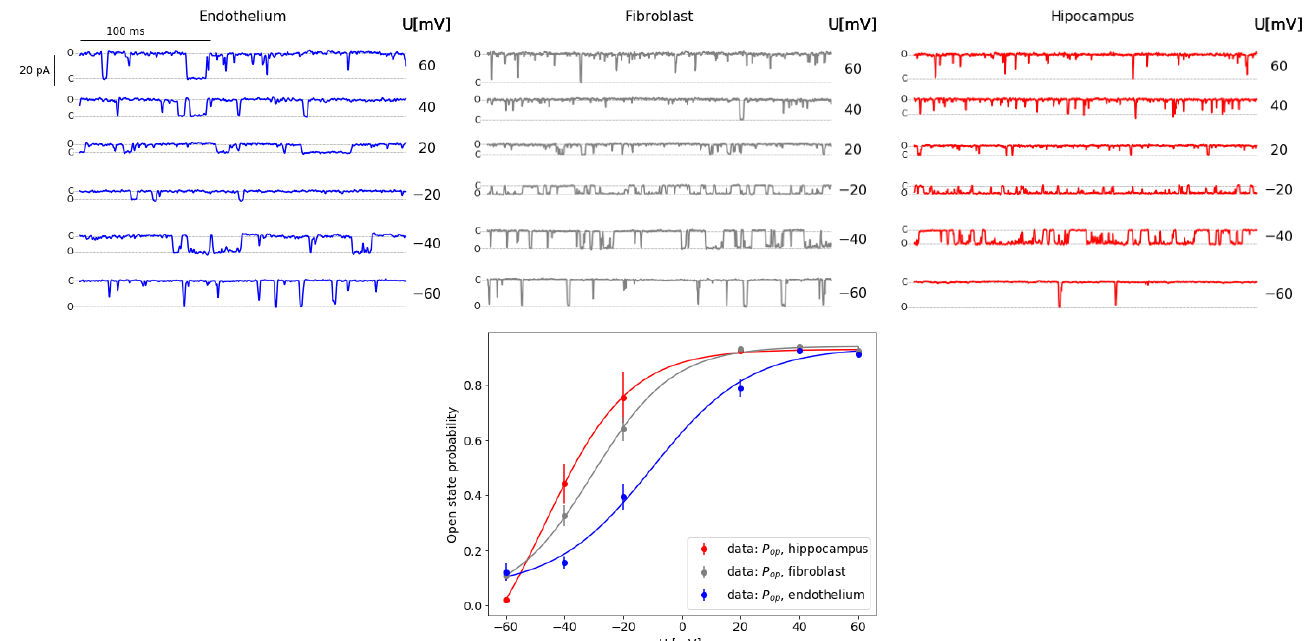
Figure 1. ( Upper ): the samples of the original ionic currents of single mitoBK channels for three different cell types: endothelium (blue); fibroblast (gray); hippocampus (red). ( Lower ): the average probability of channel opening at different membrane potentials fitted by sigmoidal